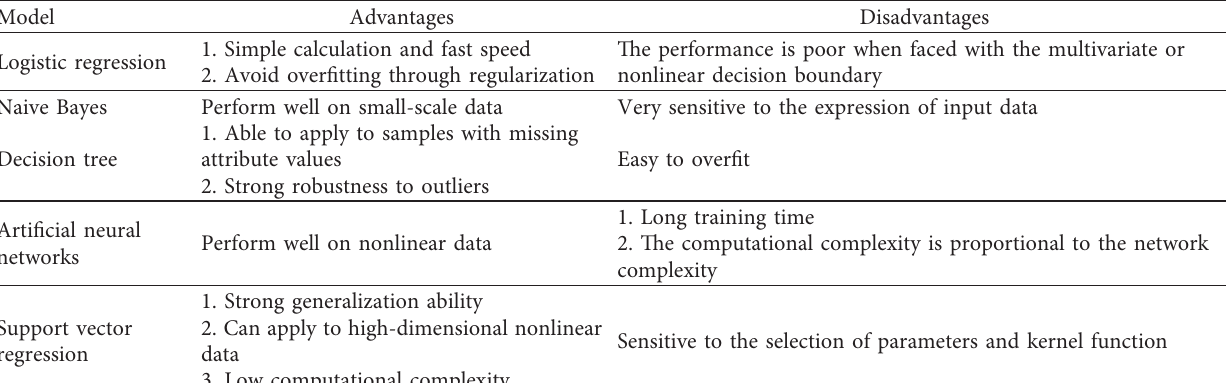
Table 1: Comparison of common machine learning methods.